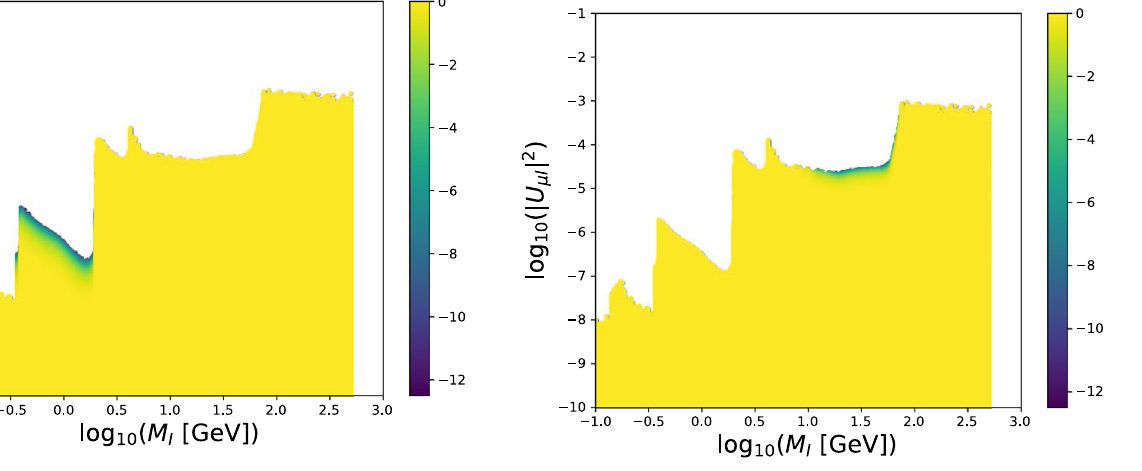
Fig. 28 Partial likelihood from direct searches with NuTeV, in the M